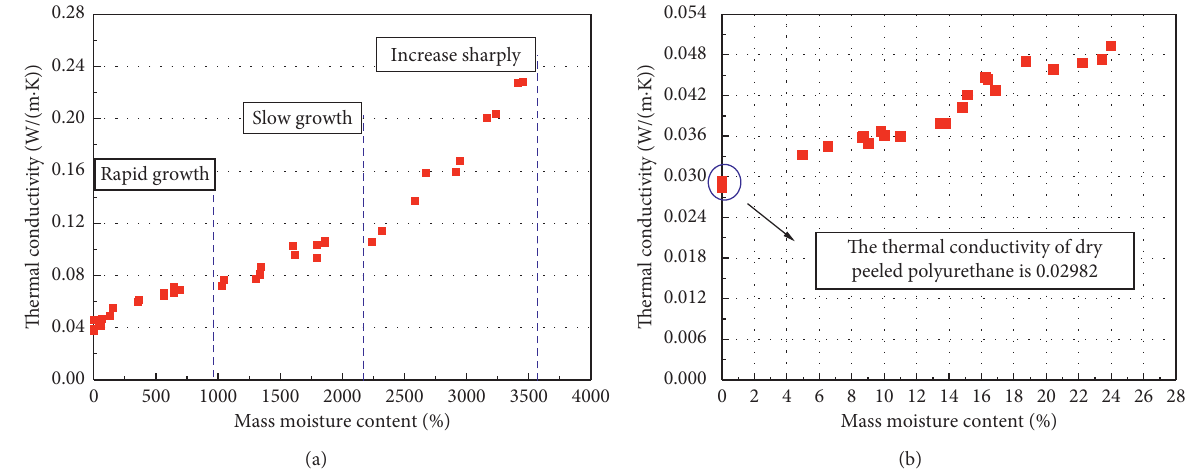
Figure 13: Thermal conductivity curves of different thermal insulation materials with different water contents. (a) Phenolic insulating board. (b) Peeled polyurethane insulating board.